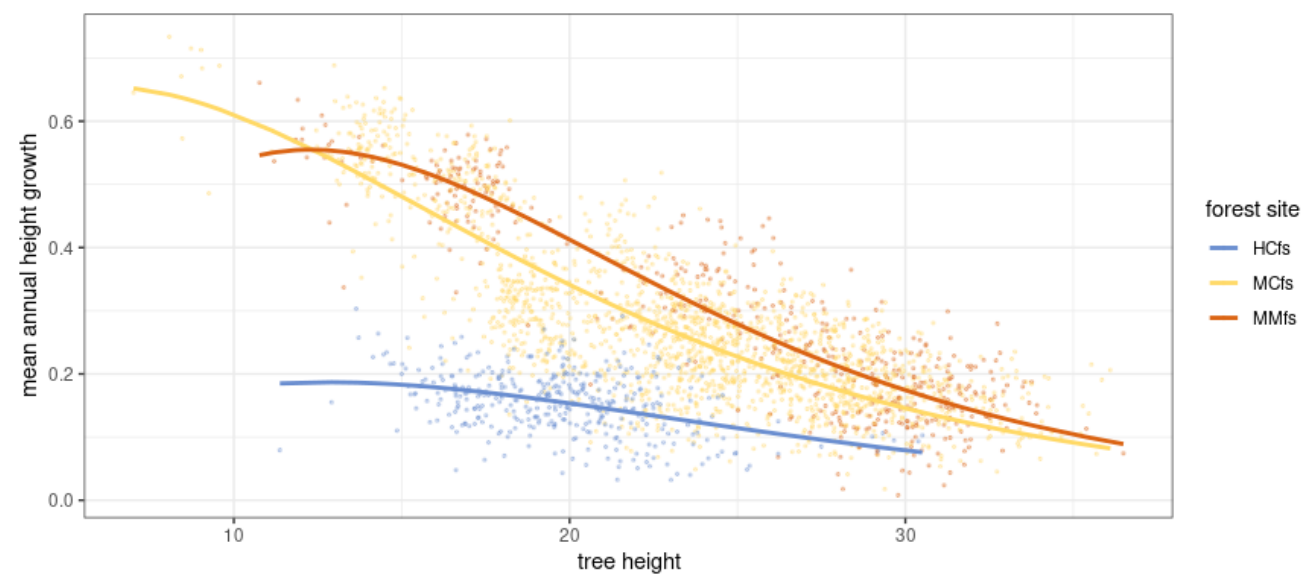
Figure 15. Incremental and elevation models of Scots pine including habitat variation against measurements. Fitted curves represent derivatives of the function describing the Gompetrz curve.